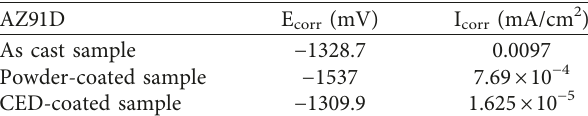
Table 11: E corr and I corr values of AZ91